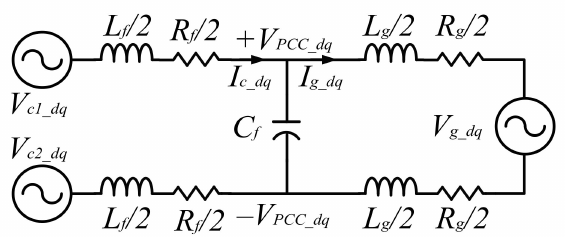
Figure 3. DTL VSI equivalent